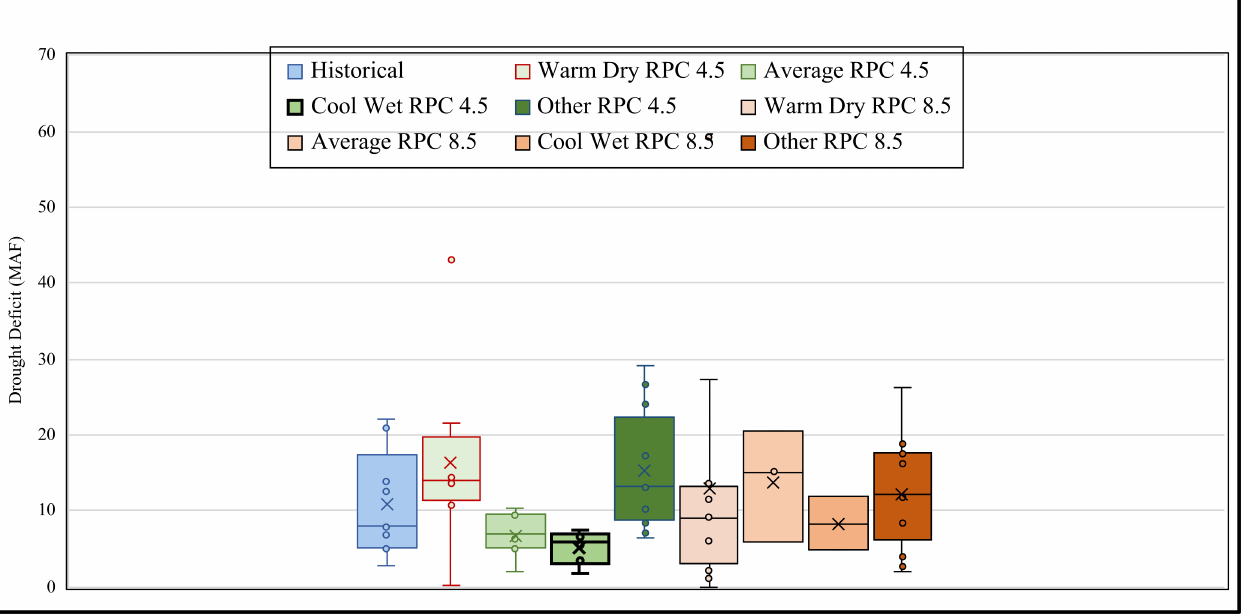
Figure 5. Box plot of San Joaquin River’s drought deficit quantities historical (1950–2015) under all projected models (2020–2099). Bottom bar and top bars extended from the box represent the lowest and highest usable values. The line in the middle represents the median value in the data. Bottom half of the box represents the lower quartile, and the top half represents the upper quartile. The highlighted boxes are significant ( p = 0.05) in terms of different from the historical distribution based on the t -test. (Note: 1 MAF = 1233 million cubic